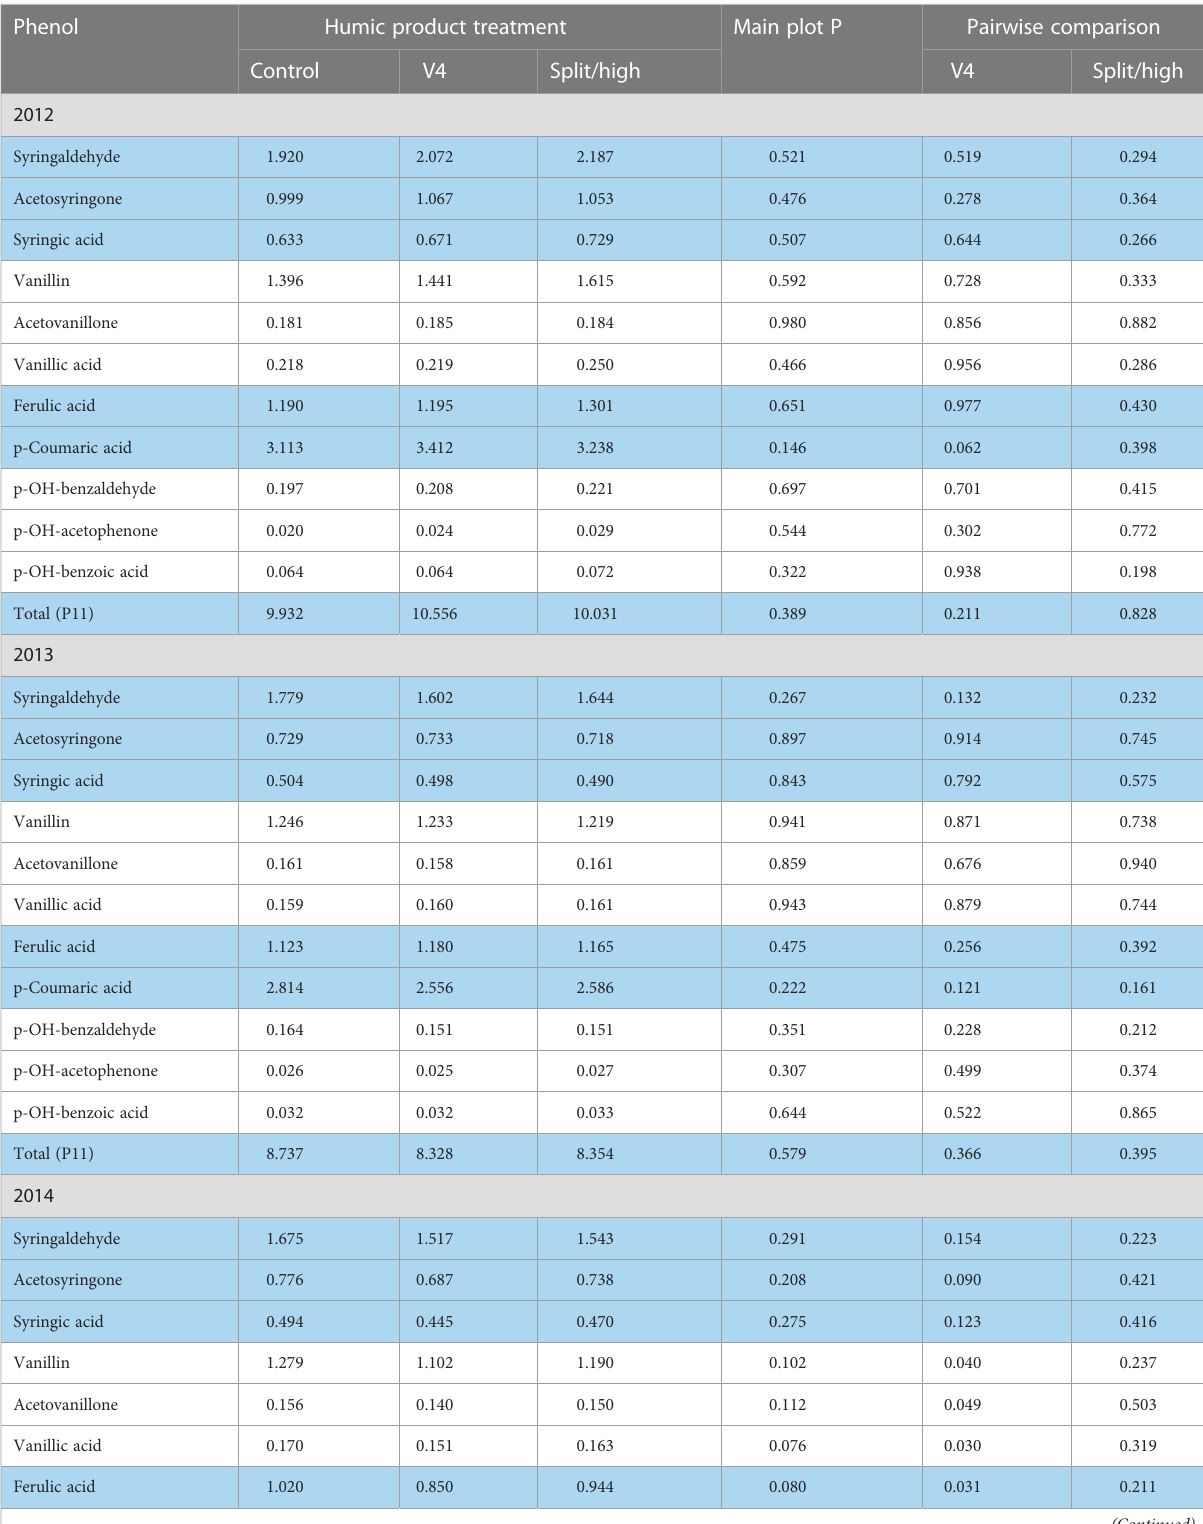
Phenol Humic product treatment Main plot P Pairwise comparison Control V4 Split/high V4